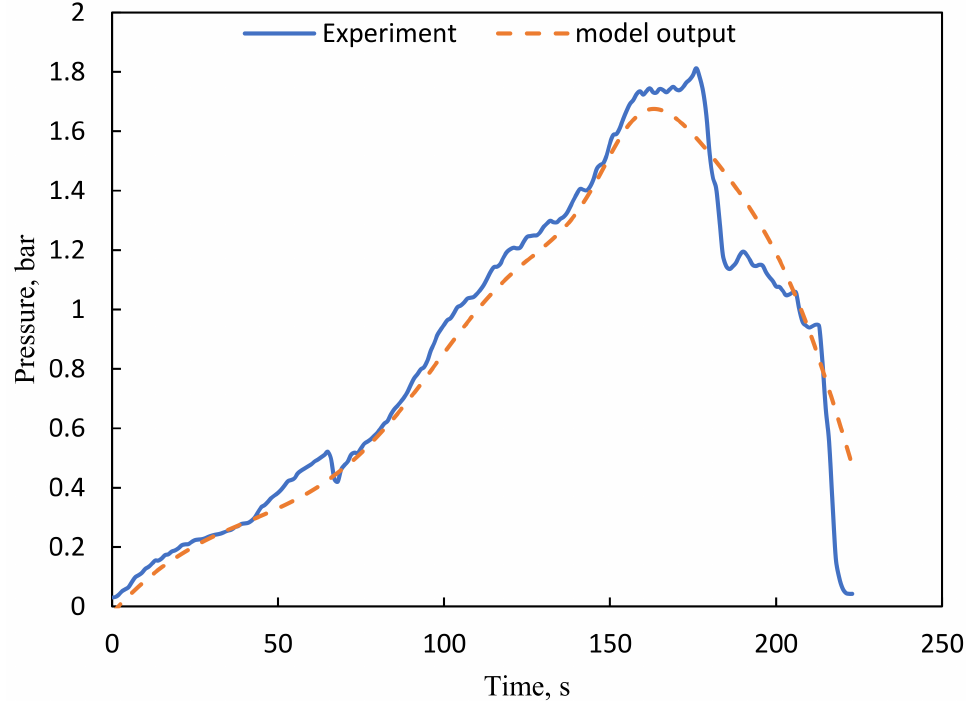
Figure 9. Comparison of the ANN model output and observation for the gradual gas injection